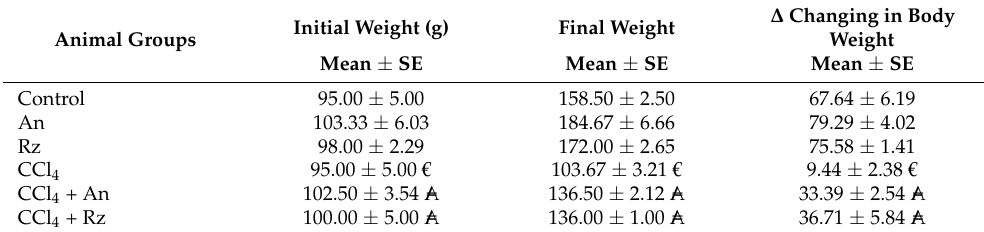
Table 4. Ameliorative effects of Anbara (An) or Reziz (Rz) administration on the changes in body weight of different experimental groups in CCl 4 -induced